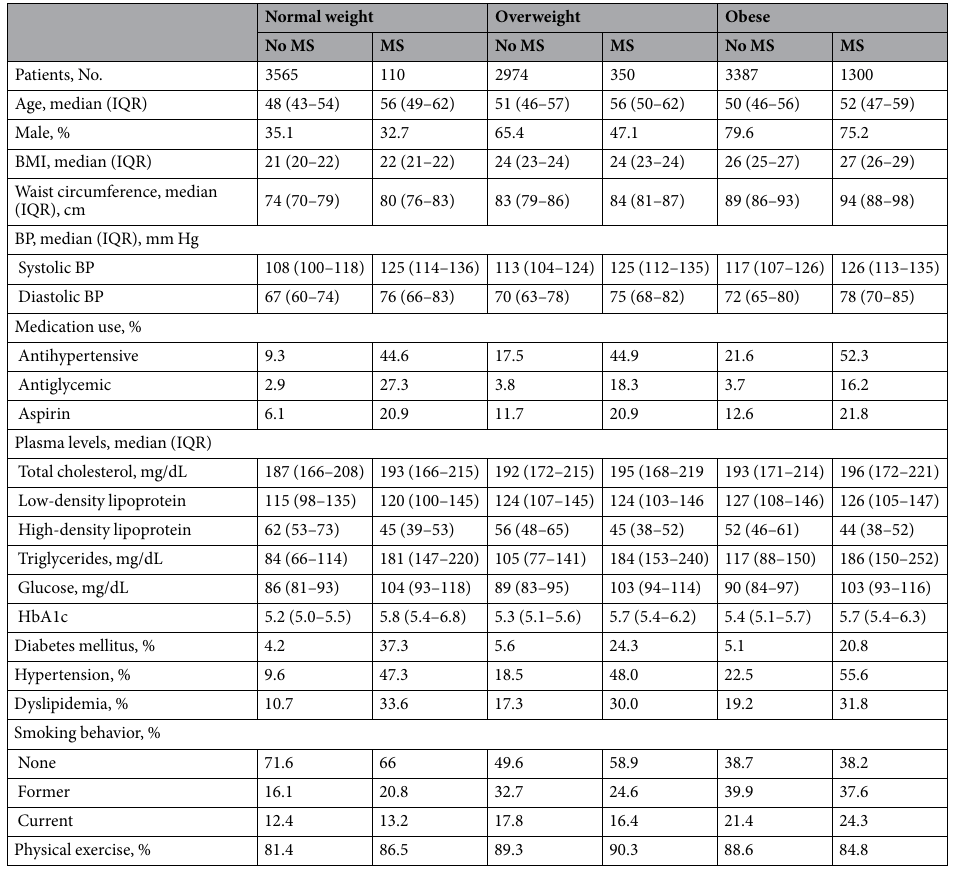
Table 1. Baseline characteristics of subjects according to body mass index categories and presence or absence of metabolic